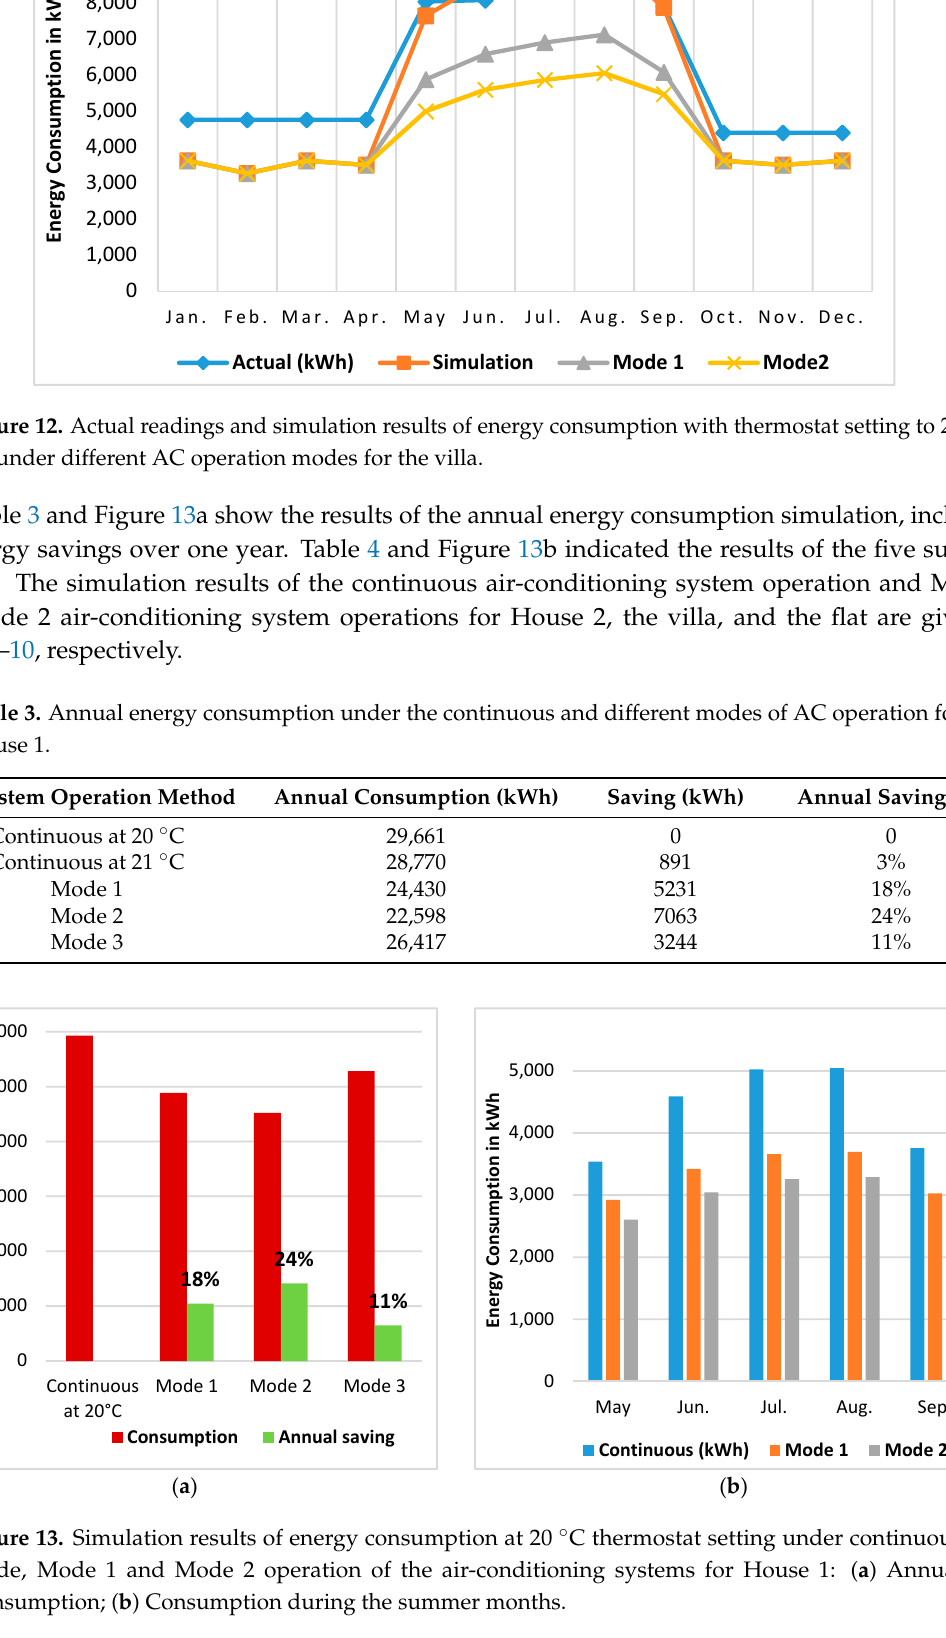
Figure 13. Simulation results of energy consumption at 20 °C thermostat setting under continuous mode, Mode 1 and Mode 2 operation of the air-conditioning systems for House 1: ( a ) Annual Consumption; ( b ) Consumption during the summer months. Table 5. Annual energy consumption under the continuous and different modes of AC operation for House 2.